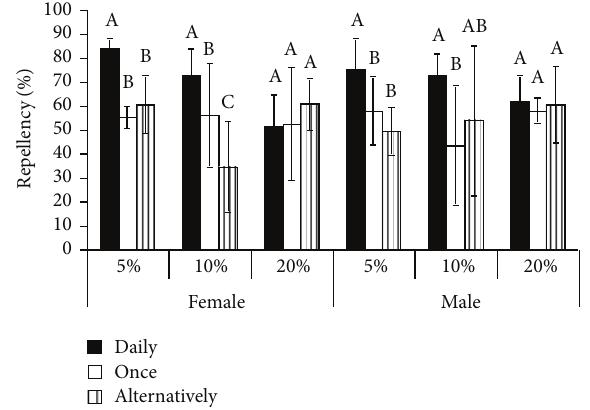
Figure 2: Significant differences in average percent repellency of eucalyptus oil in Rattus rattus among three different modes of applicationatthreedifferentconcentrationsinbothmaleandfemale rats. Bars with differ superscripts different significantly at 𝑃 ≤ 0.05